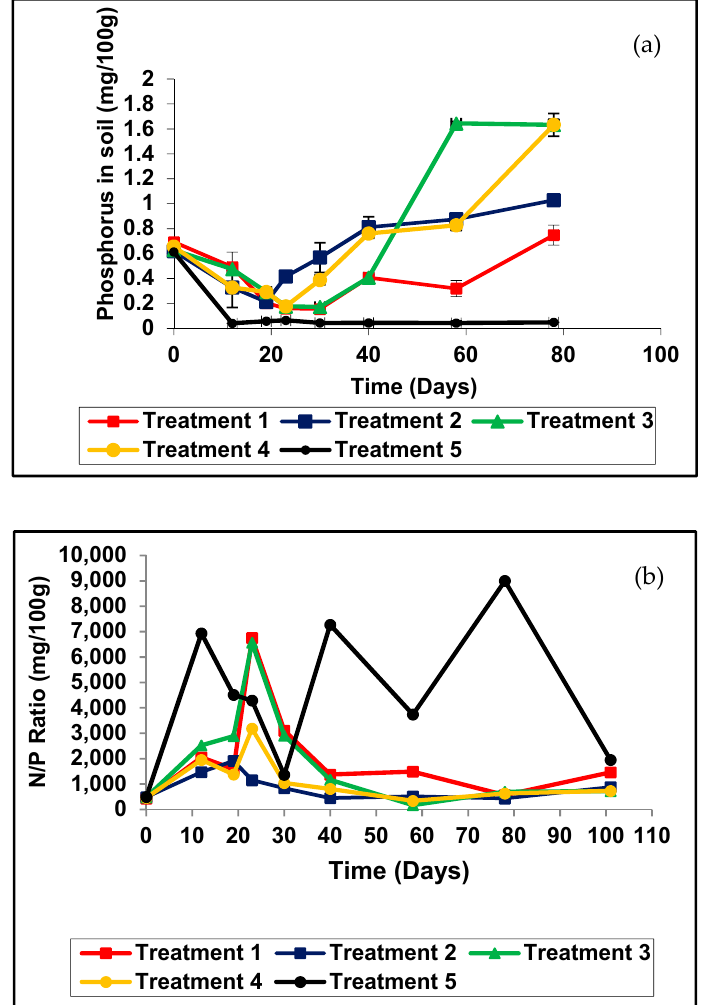
Figure 3. Phosphorus and N/P ratio variation. ( a ) Variation of phosphorus in soil with different treatments; ( b ). Influence of nitrogen on phosphorous uptake as illustrated with the ratio of nitrogen to phosphorus in the pot experiment. Each data point is a mean of four replicates. Treatment 1 − inorganic fertilizer only (Urea, TSP and MOP), Treatment 2 − rice husk biochar coated Urea, TSP and MOP, Treatment 3 − inorganic fertilizer (Urea, TSP and MOP) with anaerobically digested rice straw compost only, Treatment 4 − rice husk biochar Urea, TSP and MOP with anaerobically digested rice straw compost and Treatment 5 − no fertilizer as